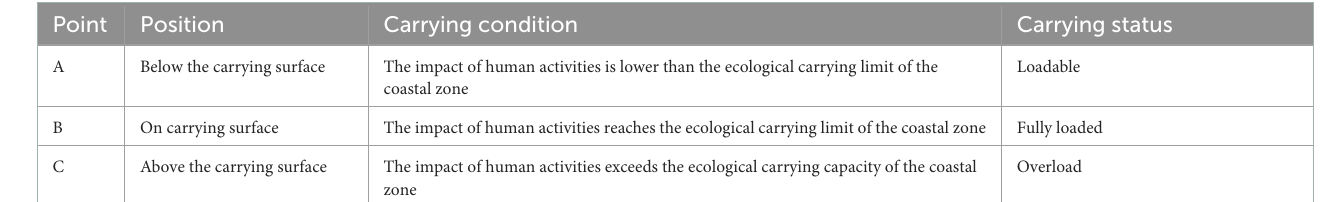
TABLE 1 Carrying states of different points in the state space model.